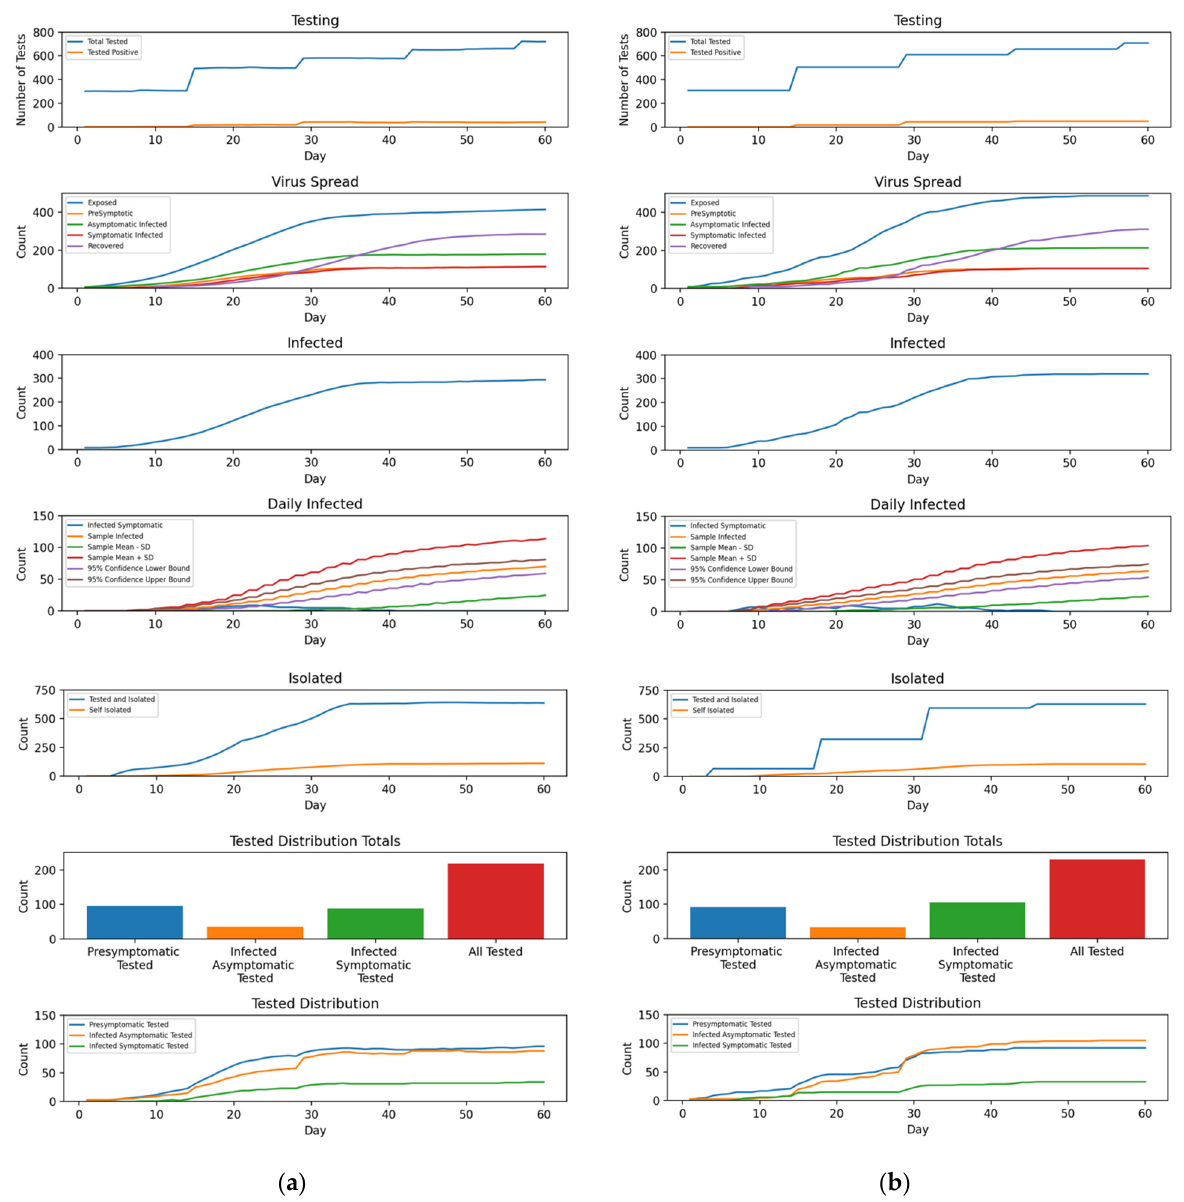
Figure 6. A prediction using our network model of a random test sample. ( a ) Predicted results for number of tests administered, virus spread, cumulative and daily infected cases, isolated population and other key distributions measures through 60 days. ( b ) Actual results for the same test sample. The student testing chart exhibits step-like structure inline with the periodically administered class testing. Infection profiles and the virus spread also display the commonly observed plateauing in the long-term dynamics of such systems, as evident in the real data.